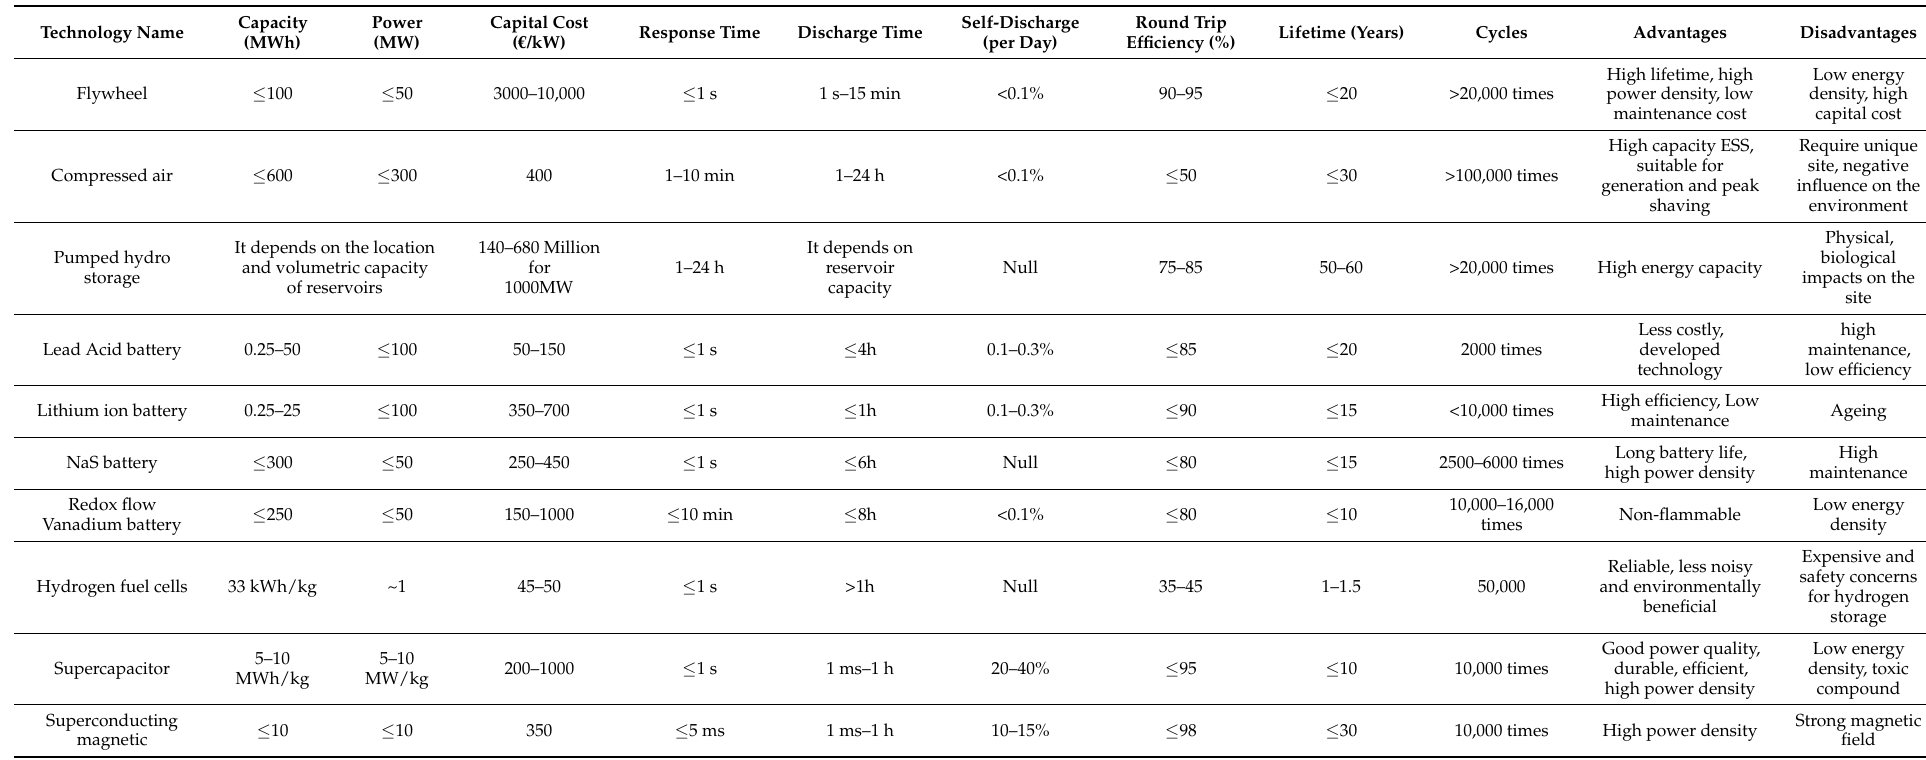
Table 1. Comparison of energy storage